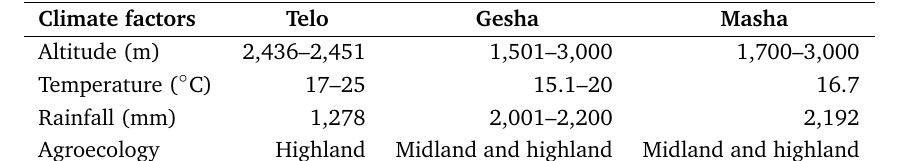
Table 1. Climatic and agroecological features of the studied areas. Data from Bezabih (2012), Assefa et al (2013), Gebrmichael (2019).